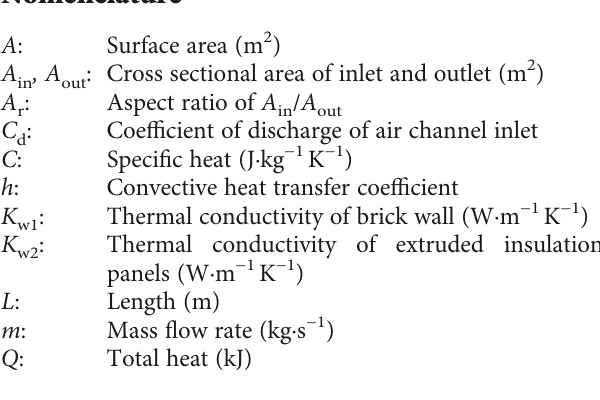
Figure 11: Comparison of numerical and experimental results: (a) absorber temperature and (b) air fl ow rate.